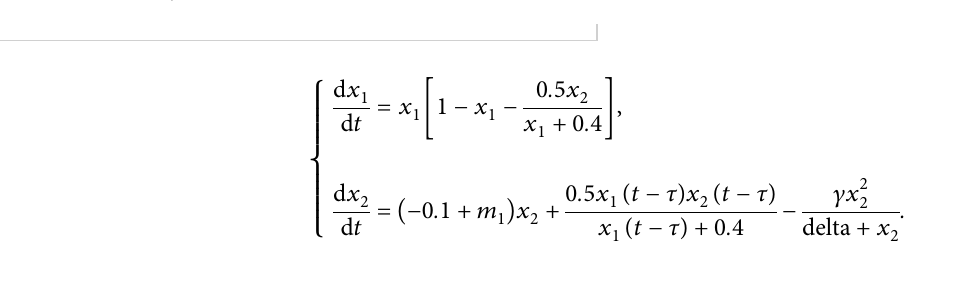
Figure 5: The bifurcation diagram of the model (51) with m